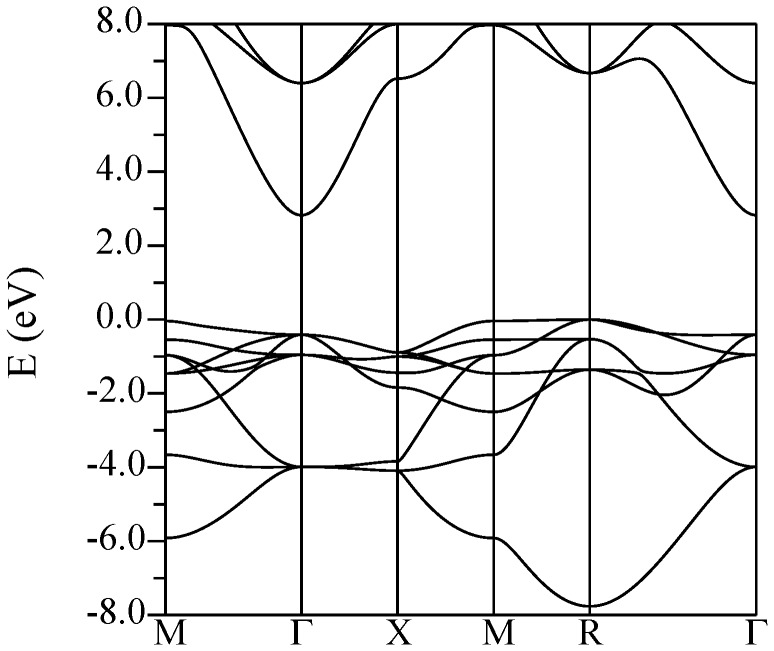
Calculated band structure of cubic BaSnO3 using the TB-mBJ potential.